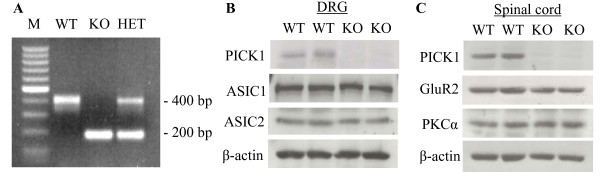
Biochemical characterization of PICK1 knockout (KO) mice. A, PCR analysis of tail DNA from wild-type (WT), heterozygous (HET), and PICK1 KO mice. M: molecular weight standard. B, Western blot analysis shows the expression of PICK1 protein and its interacting proteins ASIC1 and ASIC2 in the DRG from WT and PICK1 KO mice. C, Western blot analysis shows the expression of PICK1 and its interacting proteins GluR2 and PKCα in the spinal cord from WT and PICK1 KO mice.